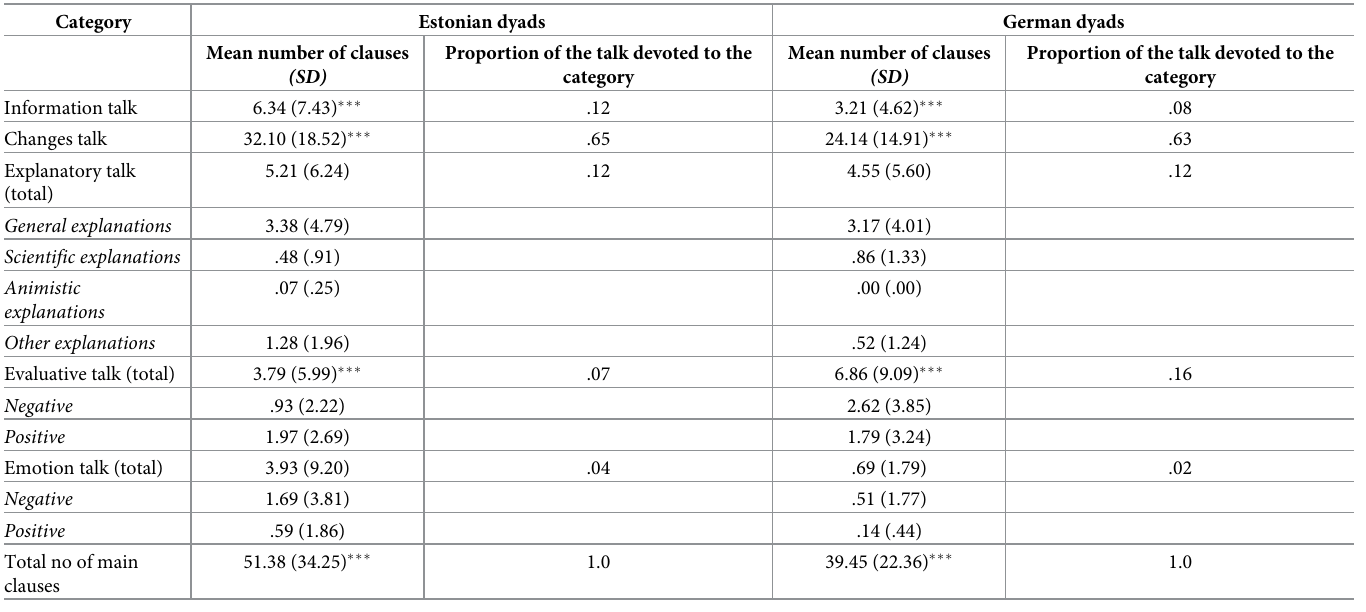
Table 3. The means, standard deviations, and proportion of talk for all the coded categories by cultural context.